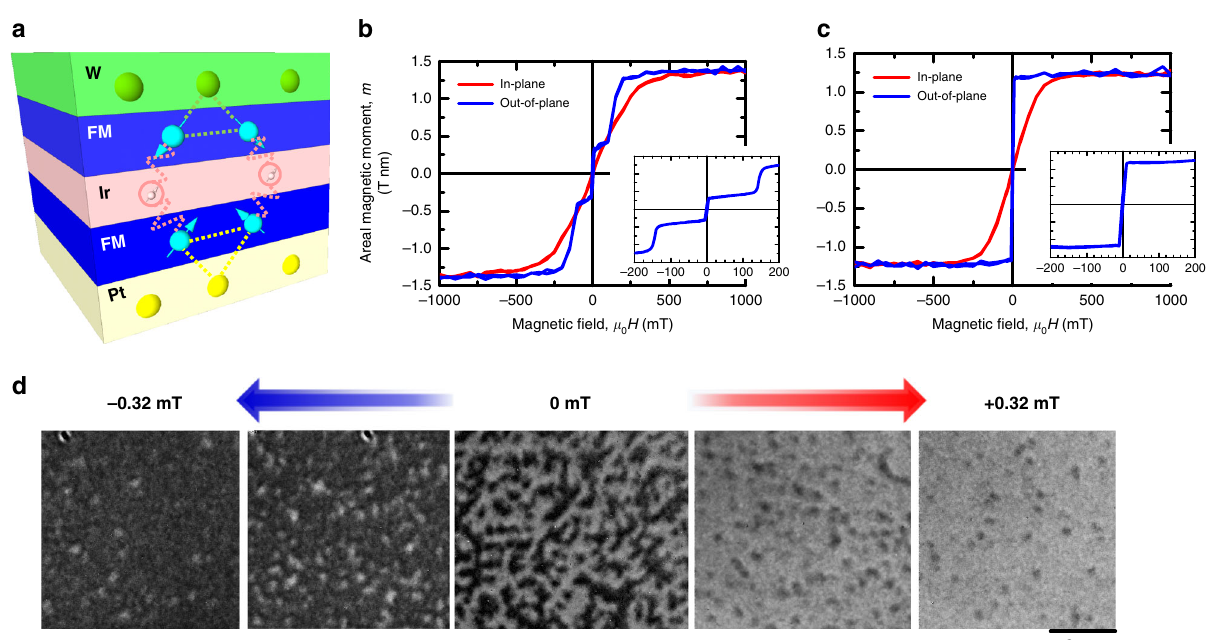
Fig. 1 Stack structure, magnetic properties and domain patterns. a Schematic of stack structure with synthetic antiferromagnetic coupling and Dzyaloshinskii-Moriya interaction. b m - H curves for stack 1 and c stack 2. Blue and red colors denote the curves along out-of-plane and in-plane directions, respectively. d Magnetic domain patterns observed by magneto-optical polar Kerr effect microscopy under magnetic fi elds of − 0.32, − 0.2, 0, + 0.2 mT, and + 0.32 mT for stack 1